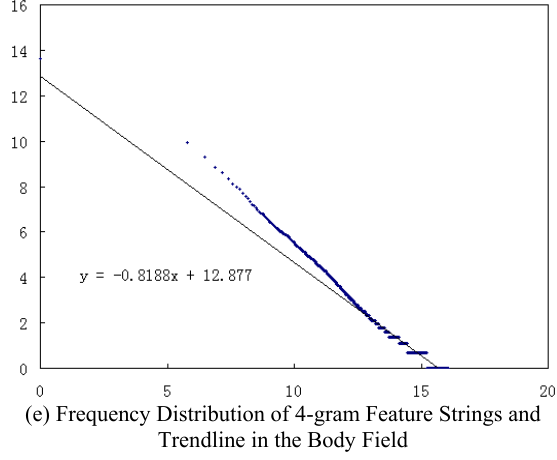
Fig. 1. Frequency Distributions of 4-gram Feature Strings and Trendlines in the Five Natural Text Fields. In each sub-figure, the horizontal-axis indicates the frequency rank of feature string (log scale), and the vertical-axis indicates the frequency of feature string (log scale). Fig. 1 includes five sub-figures corresponding to the five natural text fields of email documents. In each sub- figure of Fig. 1, the horizontal-axis (x-axis) indicates the frequency rank of feature string (log scale), and the vertical-axis (y-axis) indicates the frequency of feature string (log scale). We can draw a trendline (y = a x + b ) for each sub-figure of Fig. 1, which indicates that the number distribution of 4-gram feature strings approximately follows the power